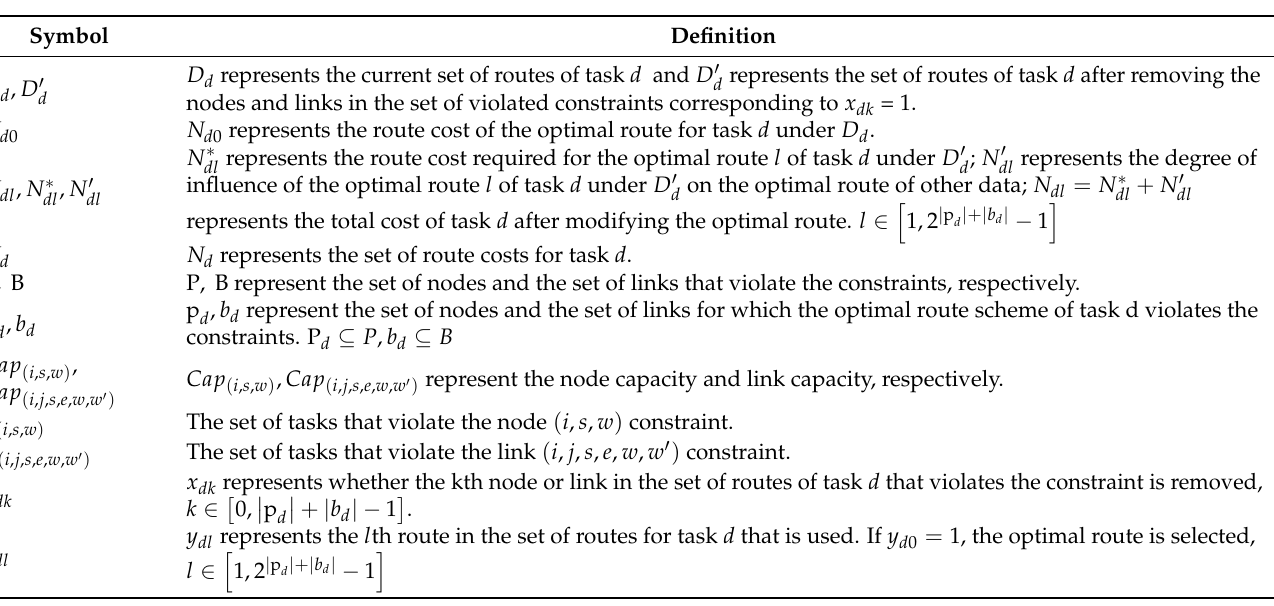
Figure 5. Explanation of tasks transmission route. Table 5. Sets, parameters, variables.